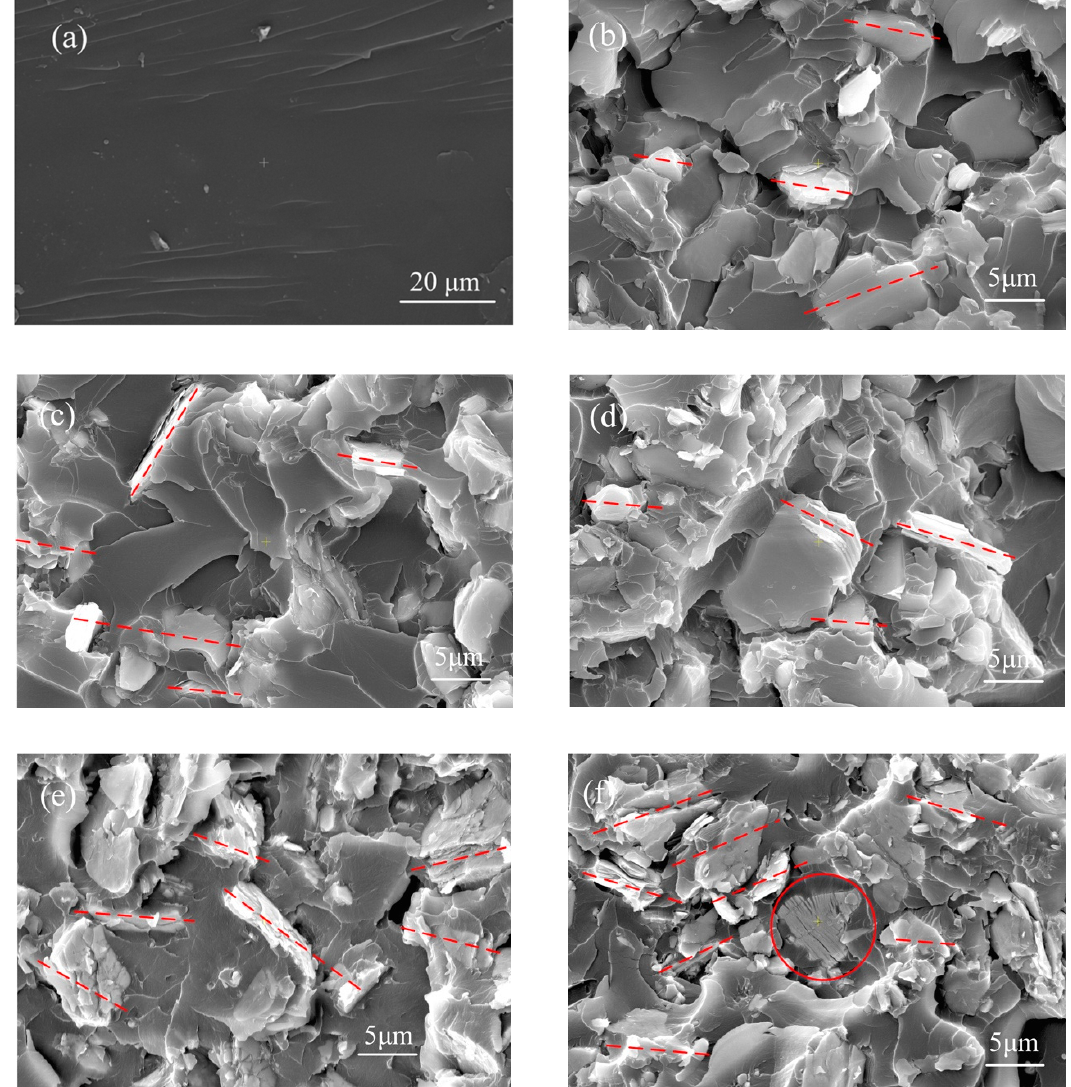
Figure 2. SEM images of cross sections of ( a ) Pure epoxy, ( b – f ) HF-Ti 3 C 2 T x / epoxy composites with filler content of 5 wt%, 10 wt%, 20 wt%, 30 wt% and 40 wt %, respectively.